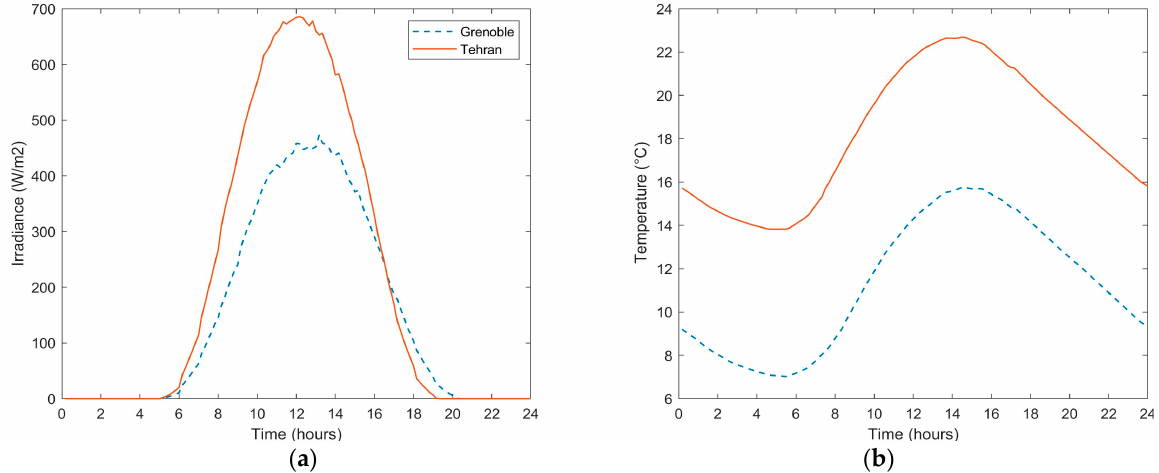
Figure 3. Mean diurnal profiles in Grenoble and Tehran. ( a ) Irradiance, ( b ) temperature.